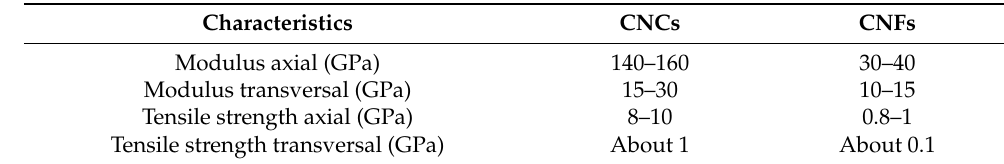
Table 2. Mechanical characteristics of cellulose nanocrystals and individual nanofibrils (CNC and CNF, respectively) [67]. Copyright 2017, Wiley